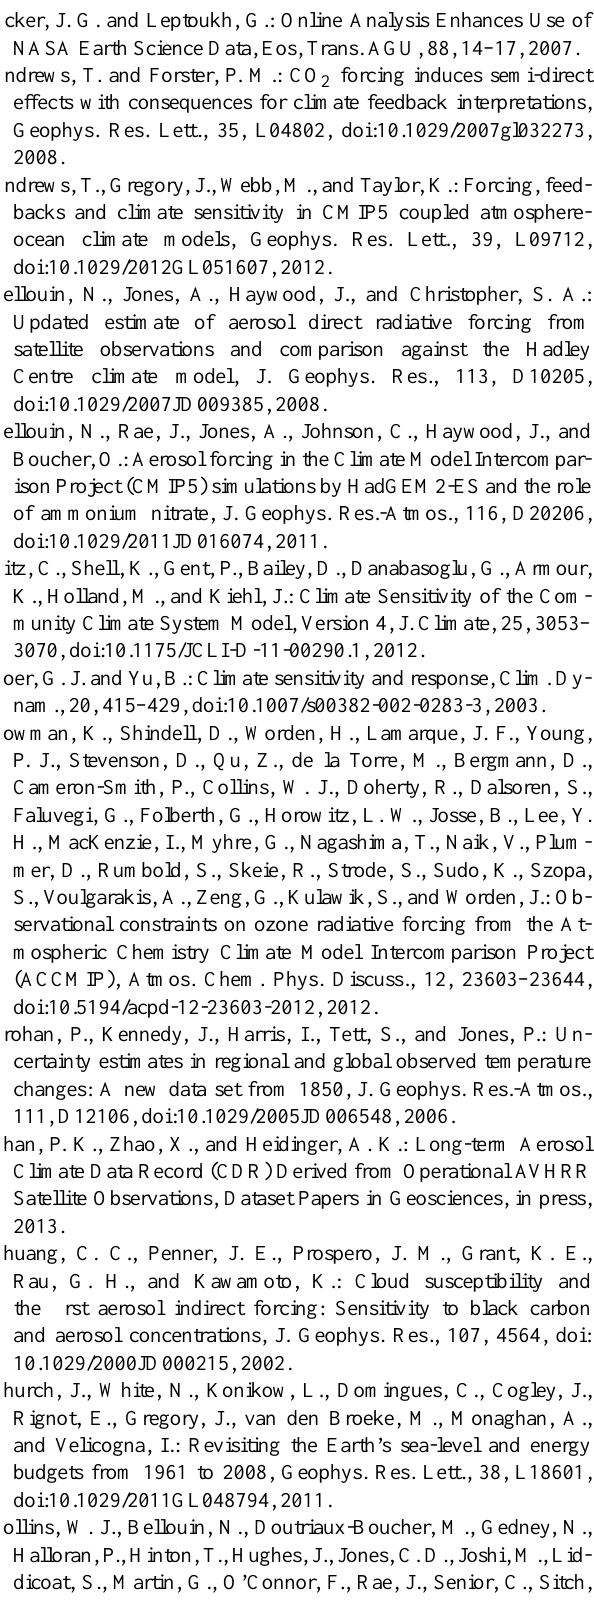
Table G2. Additional ERF values from CMIP5